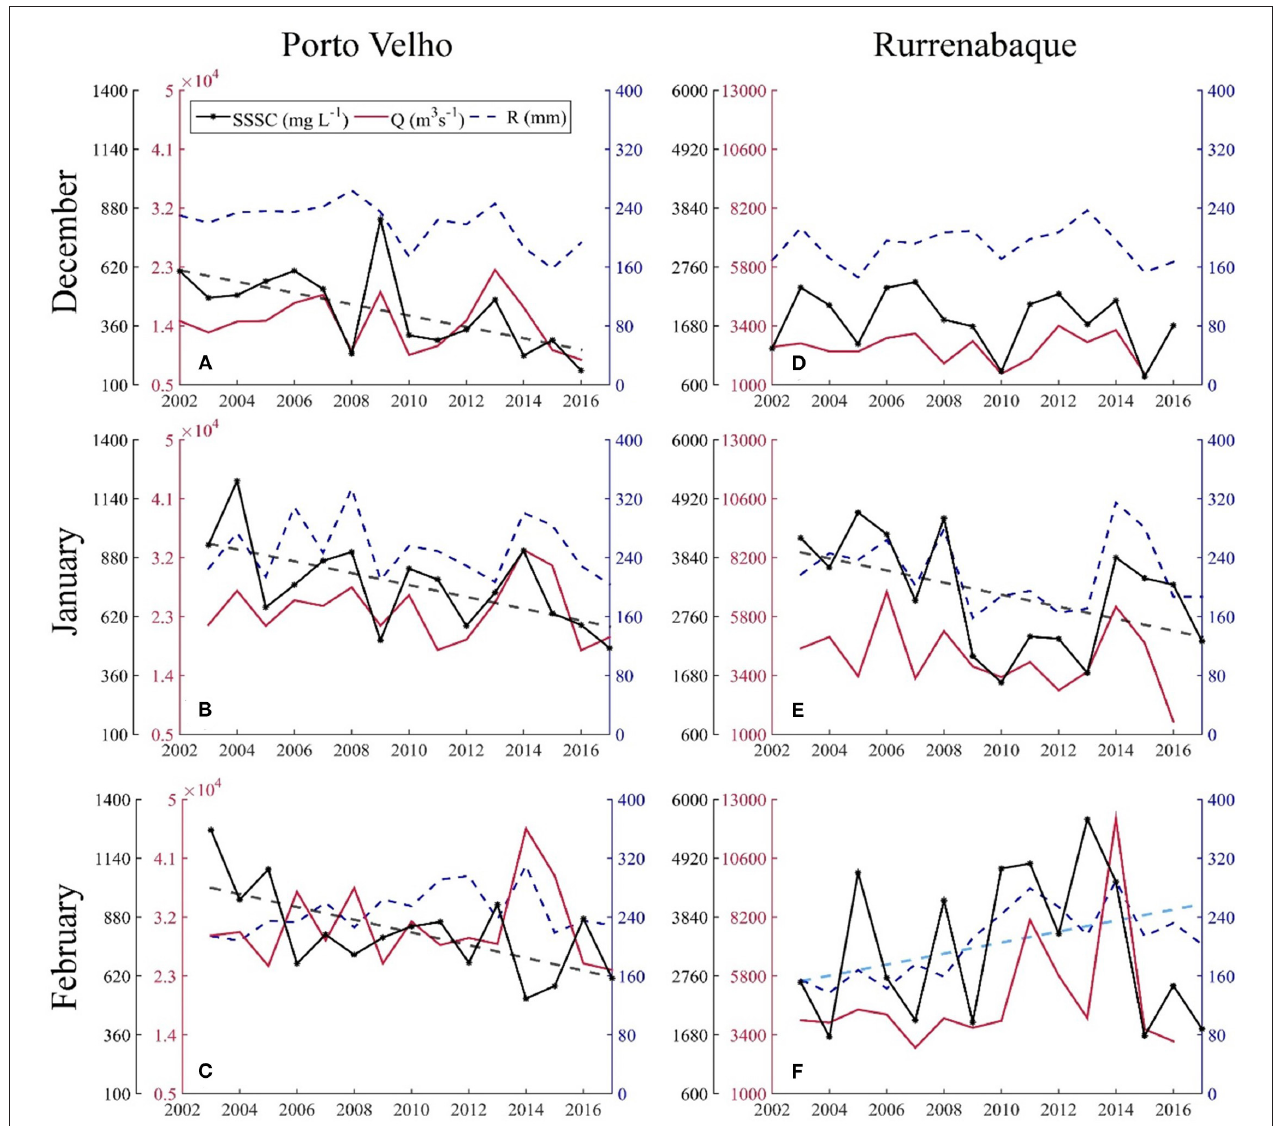
FIGURE 4 | Inter-annual rainfall (R, blue dash line), water discharge (Q, red line), and surface suspended sediment concentration (SSSC, black asterisk line) from December till February at Porto Velho on the Madeira River (A–C) and at Rurrenabaque on the Andean Beni River (D–F) . The left y-axis for SSSC (black) and Q (red), right y-axis for R: note that the left y-axis differs according to the magnitude of the variable monitored by the stations. Only significant trends ( p < 0.10) are plotted in dash